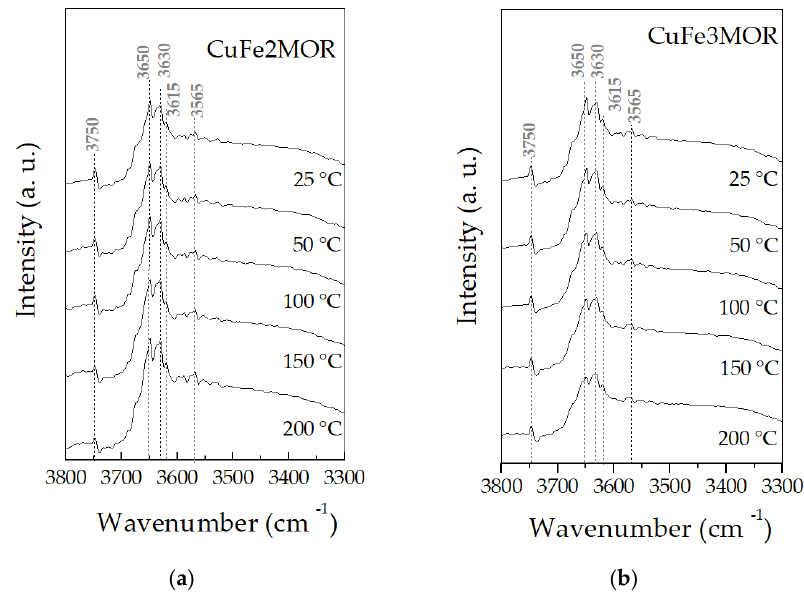
Figure 3. DRIFT spectra of hydroxyl region for ( a ) CuFe2MOR and ( b ) CuFe3MOR.